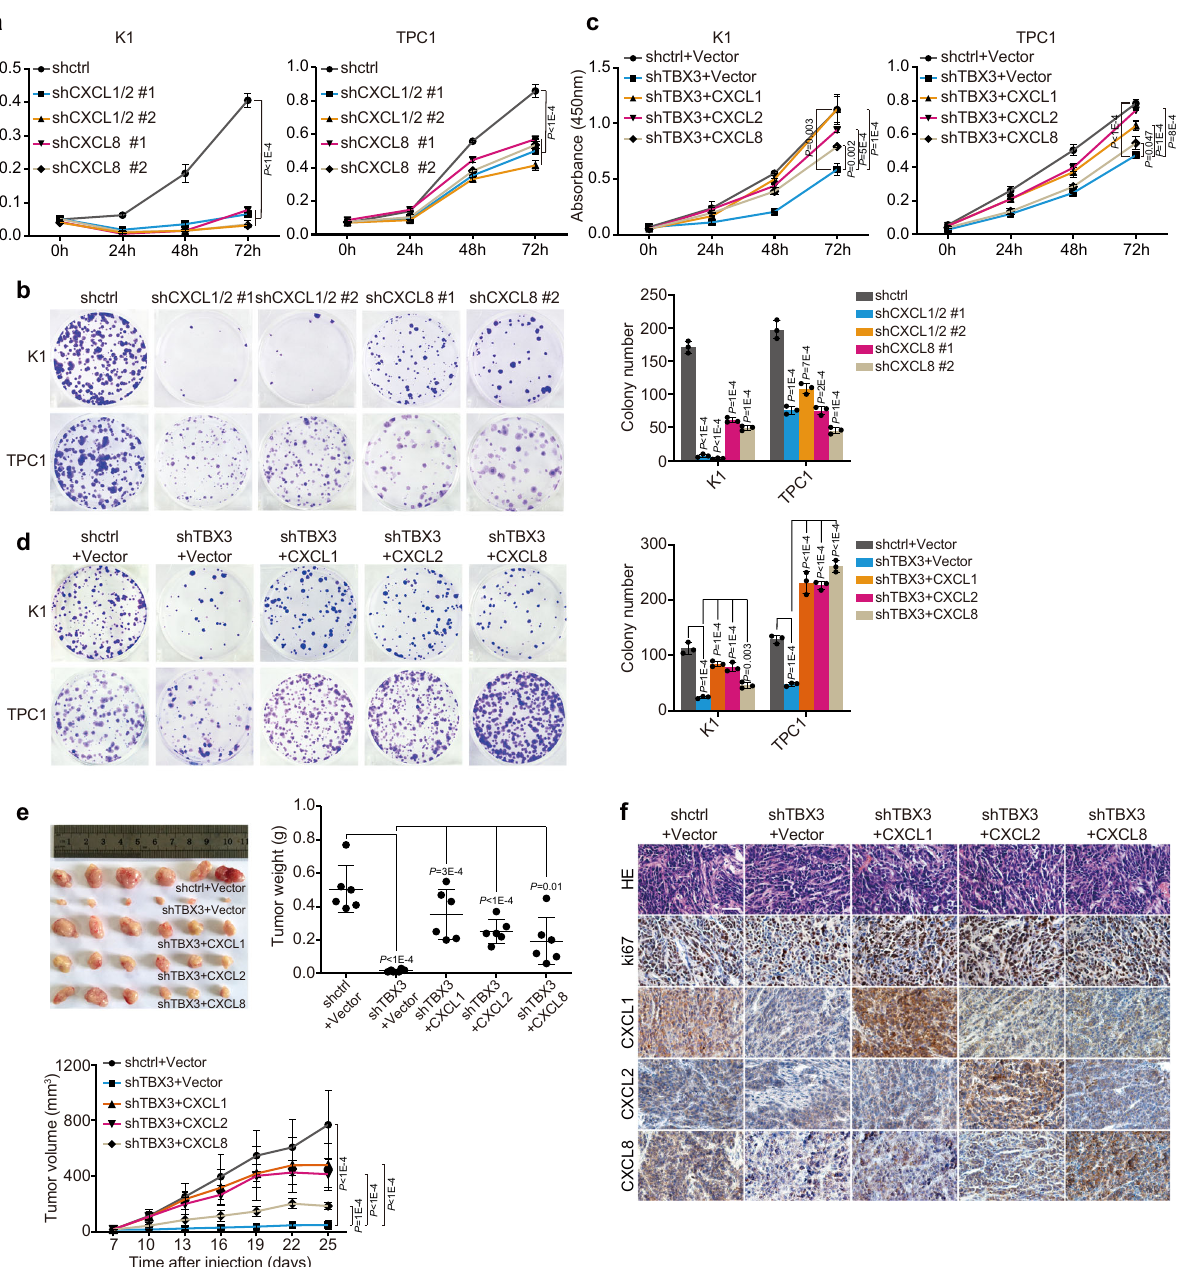
Fig. 5 CXCR2 ligands function downstream of TBX3 and promote tumor cell proliferation. a , b PTC cells were infected with speci fi c shRNA against CXCL1/2 or CXCL8, and subjected to CCK8 ( a ) or colony formation assay ( b ). c , d TBX3 knock-down PTC cells with or without CXCLs over-expression were subjected to cell growth assays of CCK8 ( c ) or colony formation ( d ). e K1 cells with TBX3 knock-down and Vector or CXCLs over-expression were transplanted into athymic mice subcutaneously. Tumor weights as well as curves were generated and statistically compared, n = 6. f HE and IHC staining of indicated factors were performed on tumor sections in ( e ). Scale bars, 50 μ m. n = 3 biological independent samples ( a – d ). Data are shown as the mean